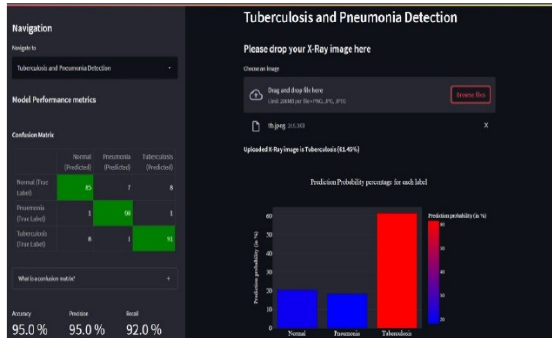
Fig. 4. Tuberculosis and Pneumonia Detection page